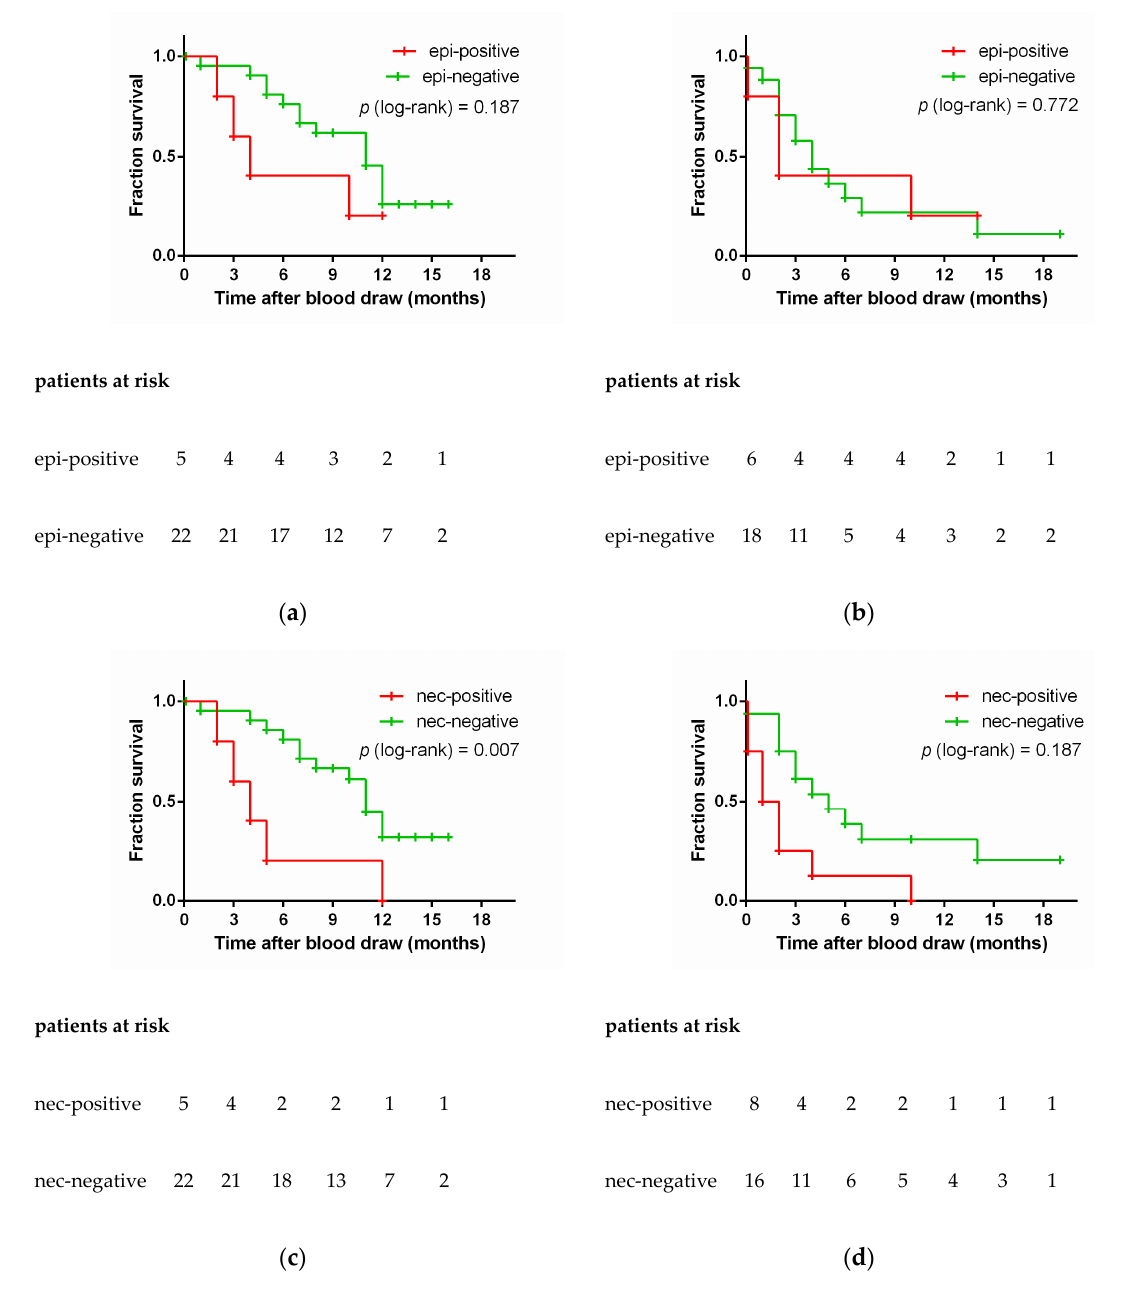
Figure 4. Overall survival of small-cell lung cancer patients according to presence (red) or absence (green) of epithelial ( EpCAM , CK19 ) and neuroendocrine markers ( SYP , CHGA ). The figures ( a ) and ( c ) display samples taken at primary diagnosis, whereas the figures ( b ) and ( d ) display samples taken at progression. Log-rank testing was used to compare survival outcomes. epi, epithelial; nec, neuroendocrine.